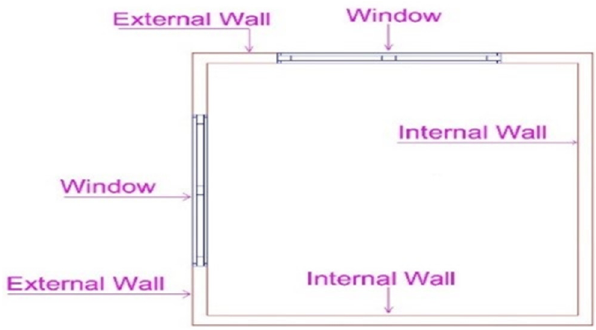
Figure 1. The layout of the reference room.